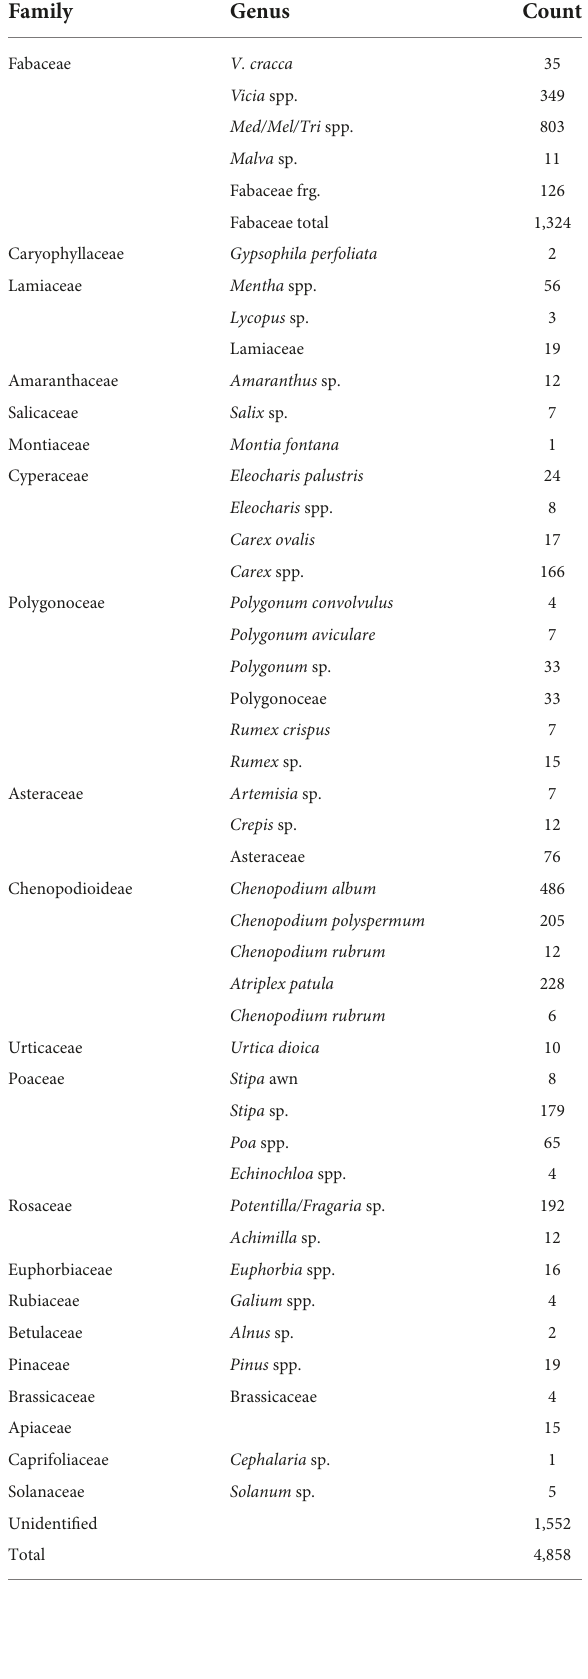
TABLE 1 The result of identifiable species in the botanical samples from stepnoye excavation